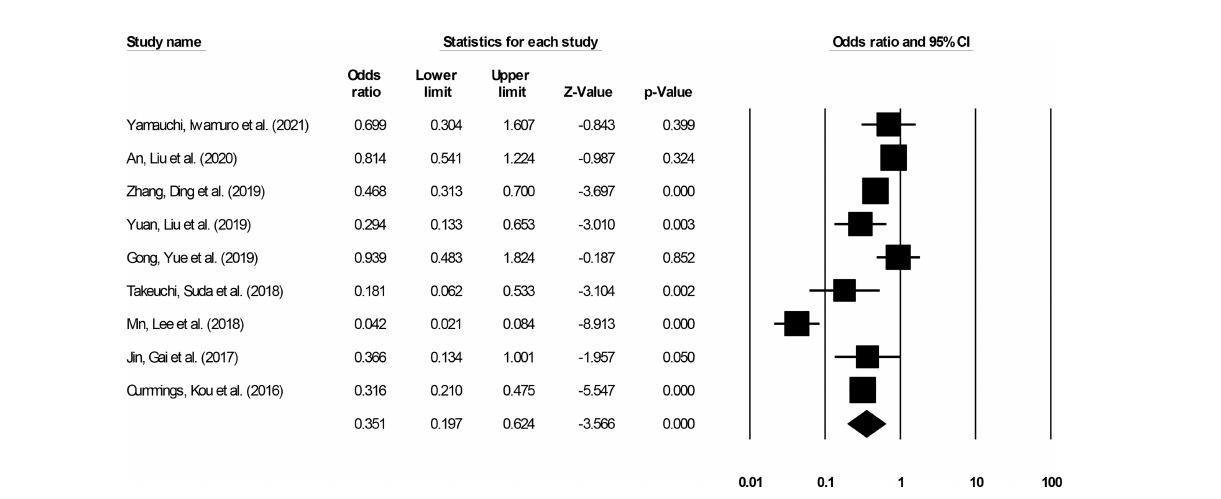
FIGURE 7 | The forest plot for studies evaluating the complication incidence in patients with super fi cial esophageal squamous cancer undergoing endoscopic submucosal dissection or esophagectomy. The odds ratios are presented as black boxes whereas 95% con fi dence intervals are presented as whiskers. A lower